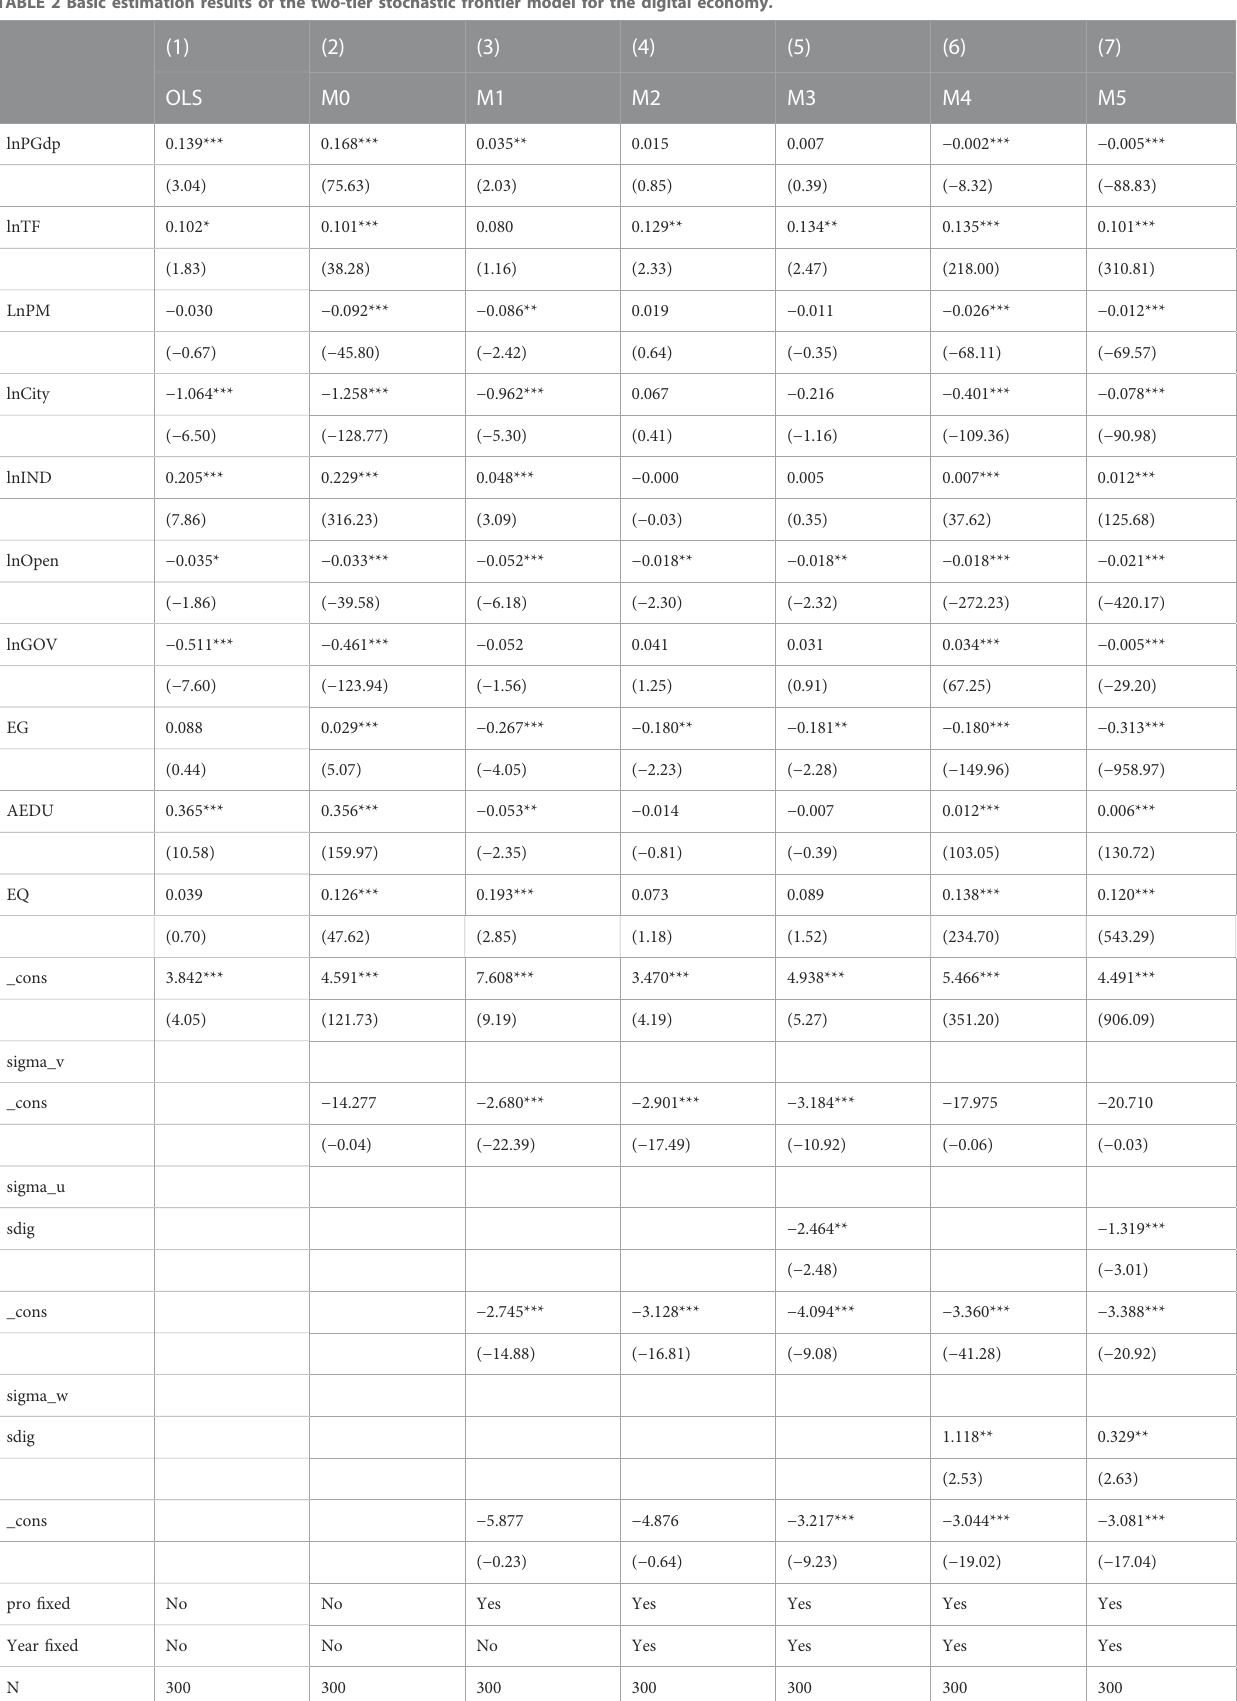
TABLE 2 Basic estimation results of the two-tier stochastic frontier model for the digital